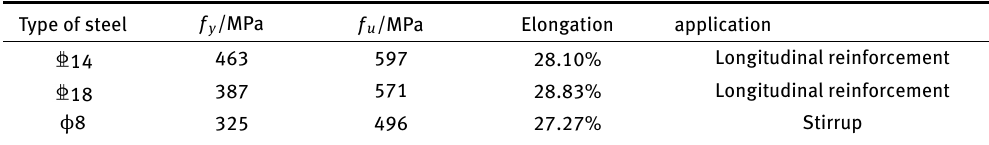
Table 2: Mechanical properties of steel bar